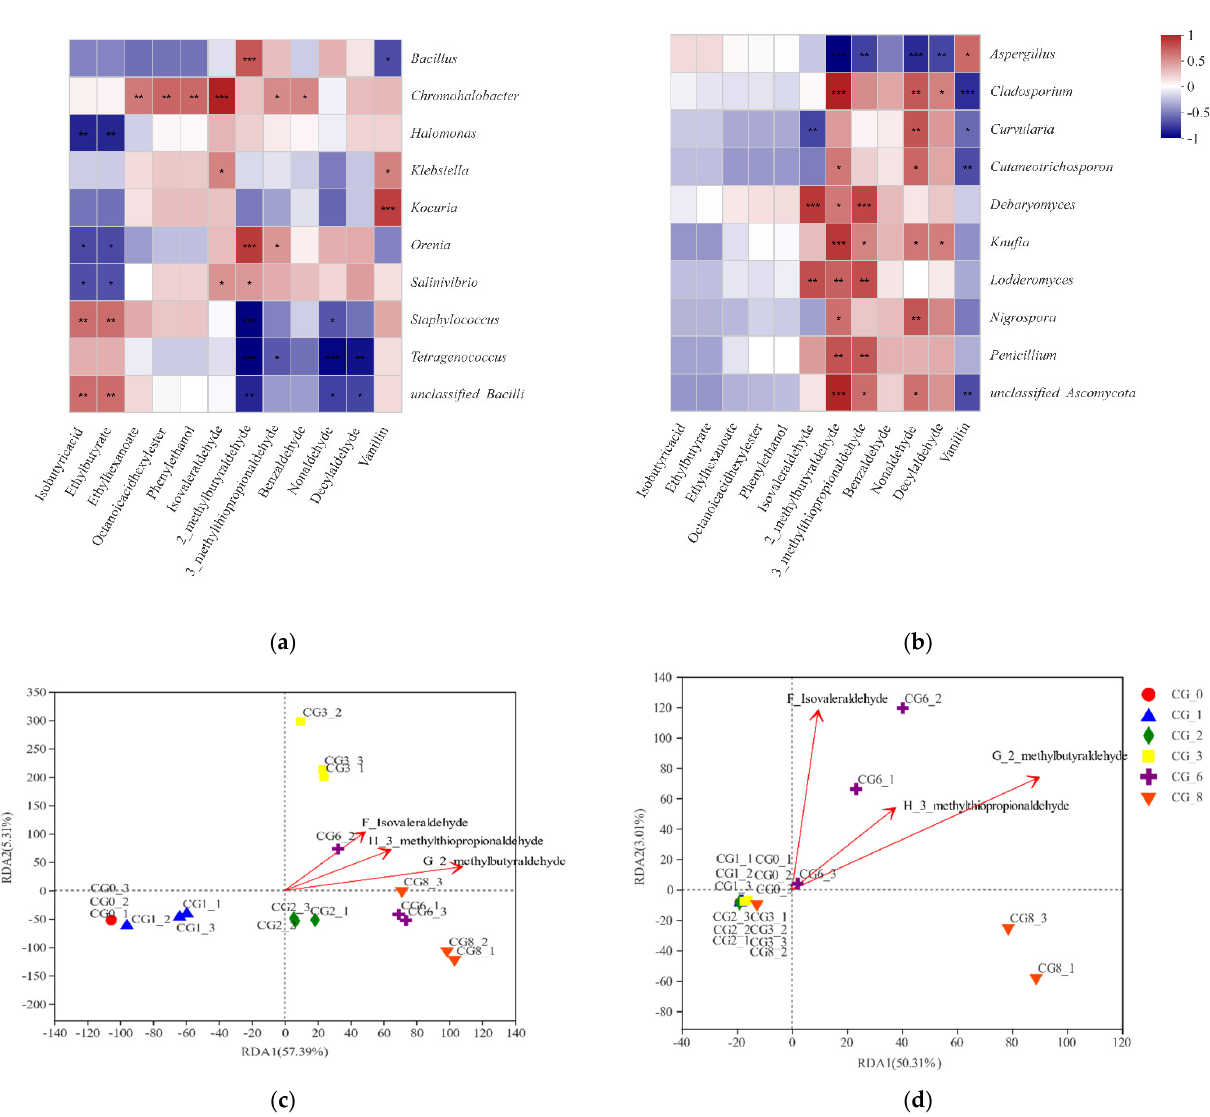
Figure 4. Heat-map ( a , b ) and RDA ( c , d ) correlation analysis of microbiota and characteristic VFCs of Caishiji bean paste in different fermentation stages. ( R value was displayed in different colors in the heat-map. If the p value was less than 0.05, it is marked with *, the legend on the right side was the color range of different R values. * 0.01 < p ≤ 0.05, ** 0.001 < p ≤ 0.01, *** p ≤ 0.001. In RDA, the red arrow indicates the flavor substance, and the length of the arrow indicates the impact degree of the flavor substance on the species; the angle between the environmental factors arrows represents positive and negative correlation (acute angle: positive correlation; obtuse angle: negative correlation; right angle: no correlation); the distance from the projection point to the origin represents the relative impact of the flavor substance on the distribution of the sample community).